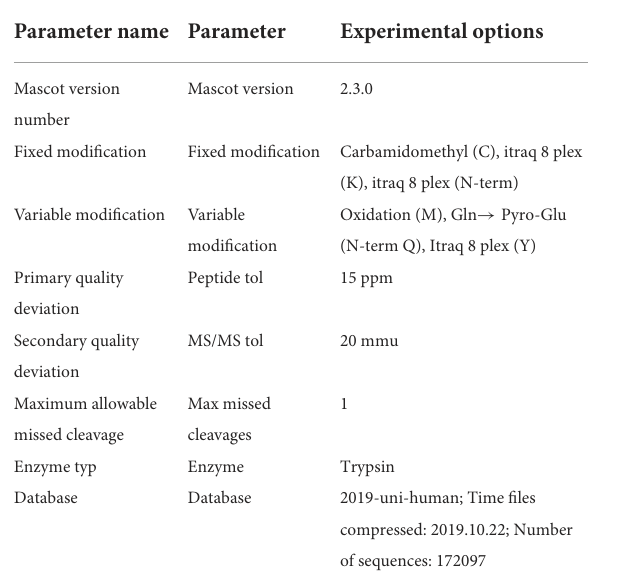
studying the mechanism of drug resistance. Over time, Caco- 2 cells gradually and spontaneously differentiate into dense cell monolayers. The structure, morphology, and function of cells at this stage are similar to human intestinal epithelial cells. One side of the brush marginal membrane differentiate into microvilli, while the other side of the serosa differentiate into the basal surface (39,